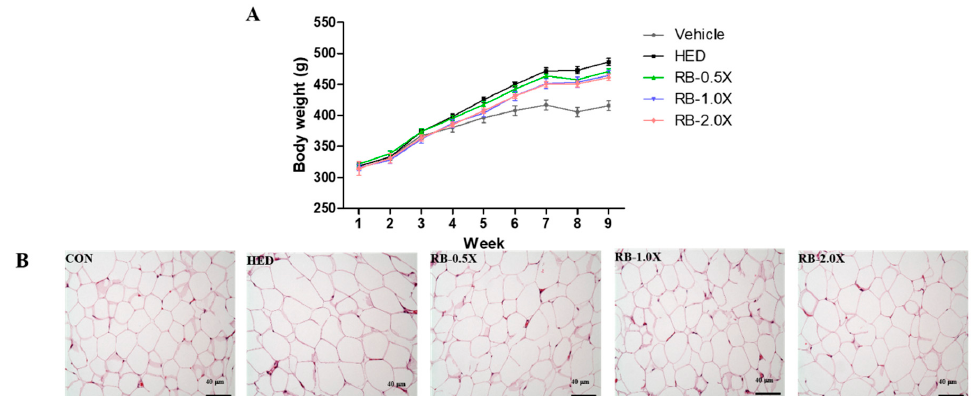
Figure 2. Effect of RB on body weight and epididymal white adipose tissue (eWAT) change in rats with HED-induced obesity. ( A ) Body weight change over time; ( B ) hematoxylin and eosin staining of eWAT sections (×100 magnification). Scale bar: 40 μ m. Vehicle, SD rat fed chow diet; HED, SD rat fed HED; RB-0.5X, SD rat fed HED with RB-0.5X; RB-1.0X, SD rat fed HED with RB-1.0X; RB-2.0X, SD rat fed HED with RB-2.0X. The data are expressed as the mean ± SE ( n = 10).